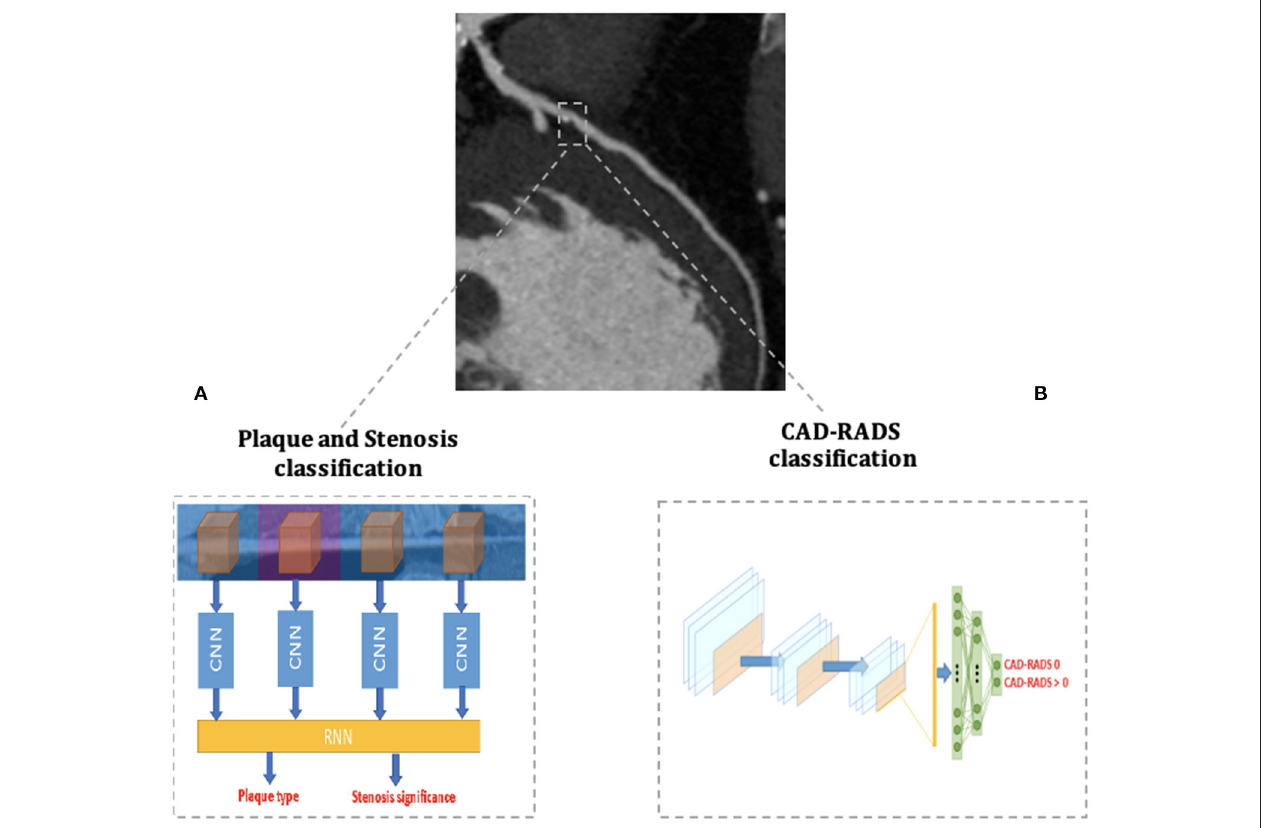
FIGURE 4 | AI applications to cardiac CT. The figure depicts two examples of AI workflow applied to the automatic analysis of coronary artery stenoses by Coronary Computed Tomography Angiography (CCTA). (A) Schematizes the algorithm proposed by Zreik et al. (72) and composed of a 3D convolutional neural network (CNN) used for coronary artery features extraction and a subsequent recurrent neural network for a two-task classification of plaque phenotype and stenosis degree. (B) Schematizes the algorithm applied by Muscogiuri et al. (68) for the fully automatic CAD-RADS classification of CCTA scans with a